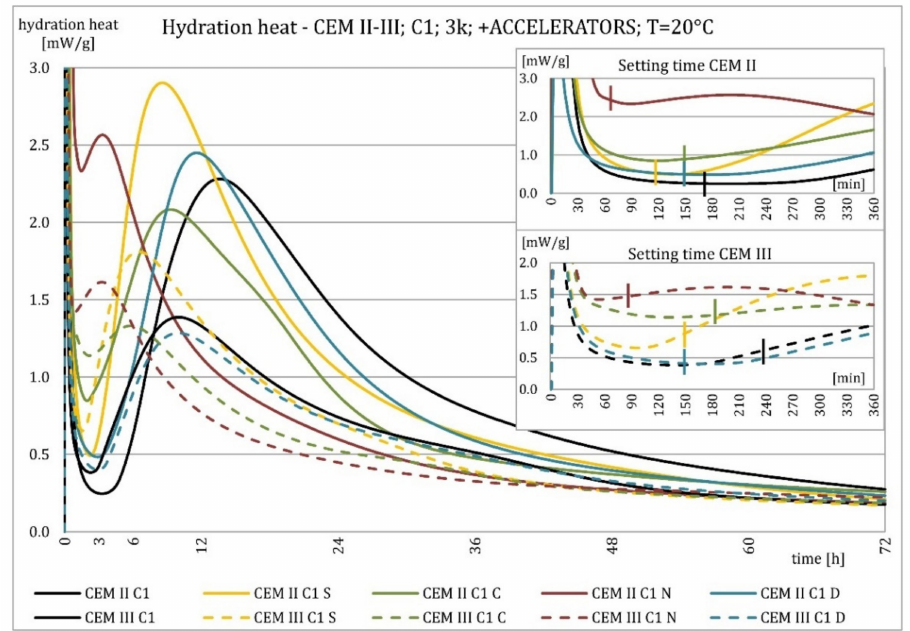
Figure 20. Hydration heat of C1 clinker-based cements CEM II/B-S, CEM III/A modified with accelerators at 20 ◦ C.